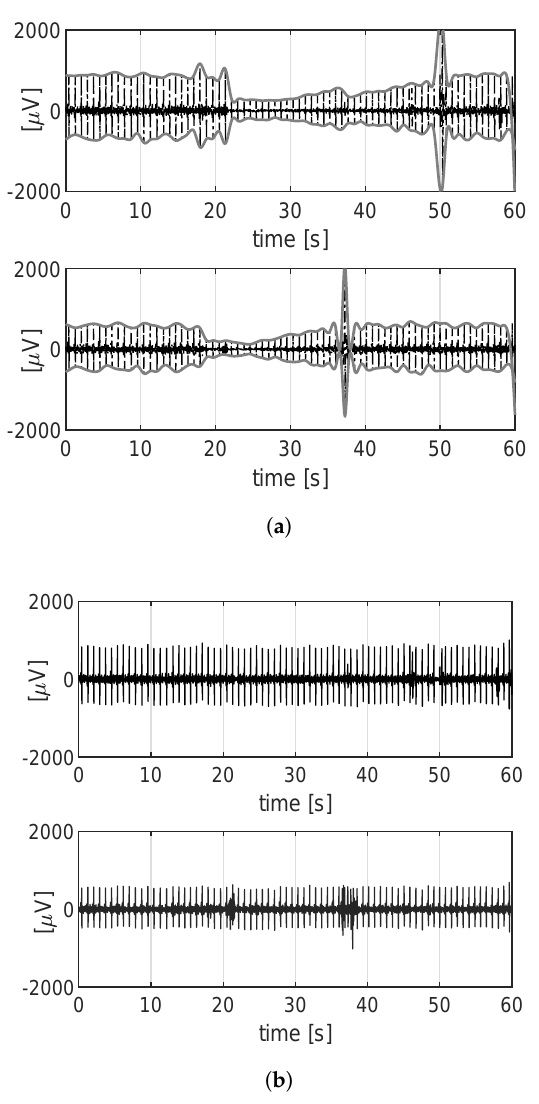
Figure 5. ( a ) Raw signals (black) affected by the amplitude modulation and the positive and the neg- ative envelops (grey). ( b ) How the related signals appear after the compensation of the modulation. Each bipolar measurement y i with i = 1, . . . , 4 was a row of the matrix Y ( 4 × N ) , where N is the number of samples acquired during one-minute